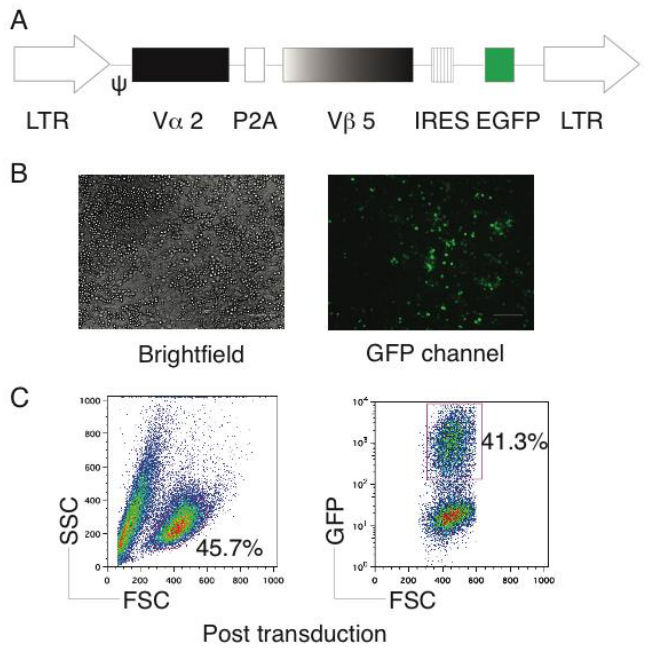
Figure 1. Genetic modification of HSCs with Ag-specific TCR. Bone marrow-derived CD117 + Lin - HSCs from C57BL/6 mice were transduced with the retroviral constructs Mig-TCR, which contains ovalbumin (OVA)-specific TCR (Mig-TCR) and enhanced Green Fluorescent Protein (GFP). ( A ) Schematic representation of the retroviral construct Mig-TCRVα2-2A-TCRVβ5 expressing OVA-specific TCR. Ψ, packaging signal; 2A, picornavirus self-cleaving 2A sequence; LTR, Long terminal repeats. ( B ) TCR-transduced HSCs were visualized by fluorescence microscopy (scale bars: 50 μm). ( C ) TCR-transduced HSCs were analyzed by flow cytometry (left) and GFP + cells were sorted by a high-speed cell sorter (right). Data are representative of three independent experiments.